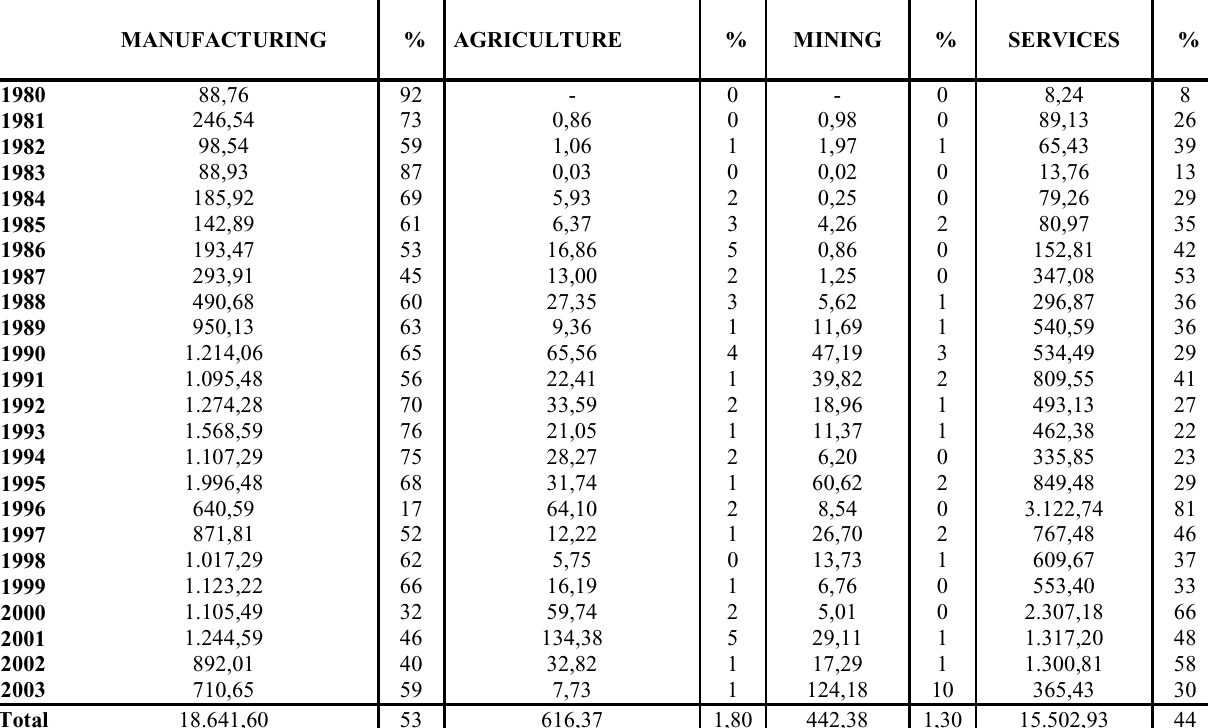
Table 2 . Sectoral Breakdown of Authorized FDI in Turkey, 1980–2003, Million $